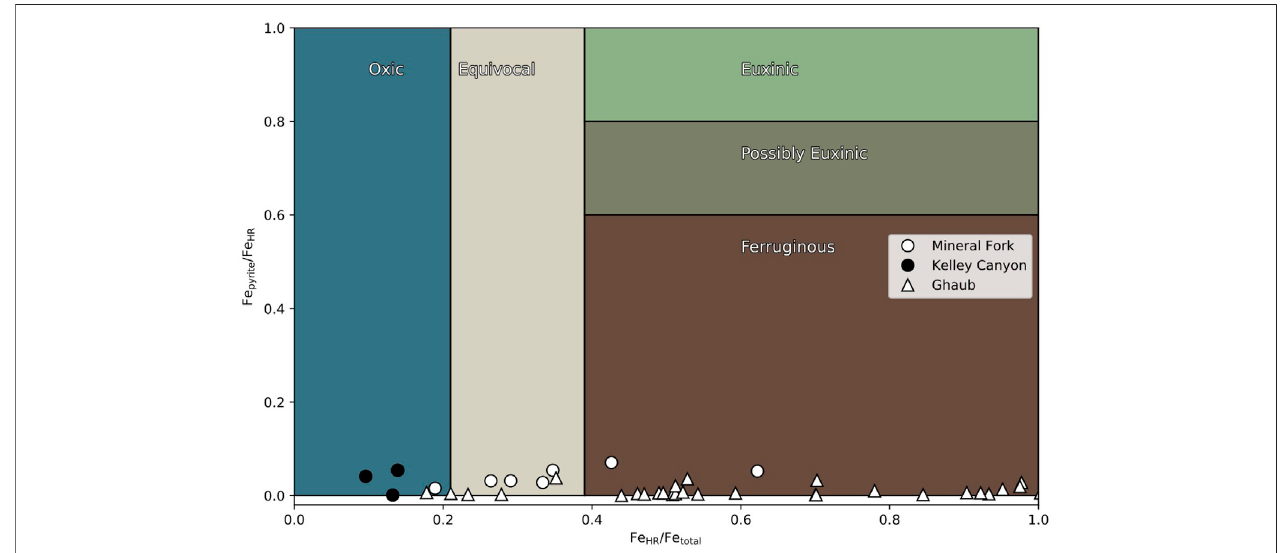
FIGURE2| IronspeciationdatafromtheMineralforktillite(circles),KelleyCanyonFormation( fi lledcircles)andtheGhaubFormation(triangles).Somesamplesfrom both settings plot in the fi elds characteristic of oxic bottom waters. Speci fi cally, Kelley Canyon samples re fl ect oxic bottom waters with some samples from the Ghaub formation as